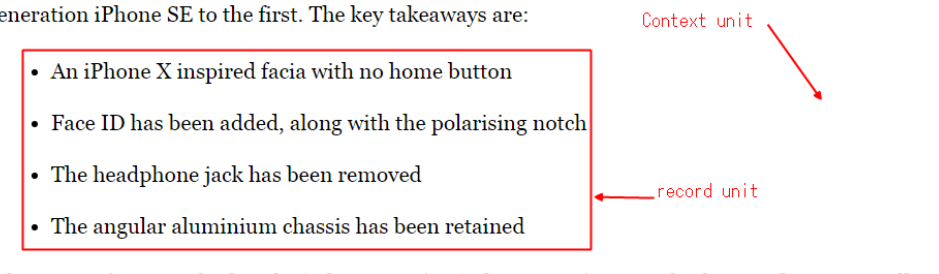
Figure 2. Example of the context unit and the record